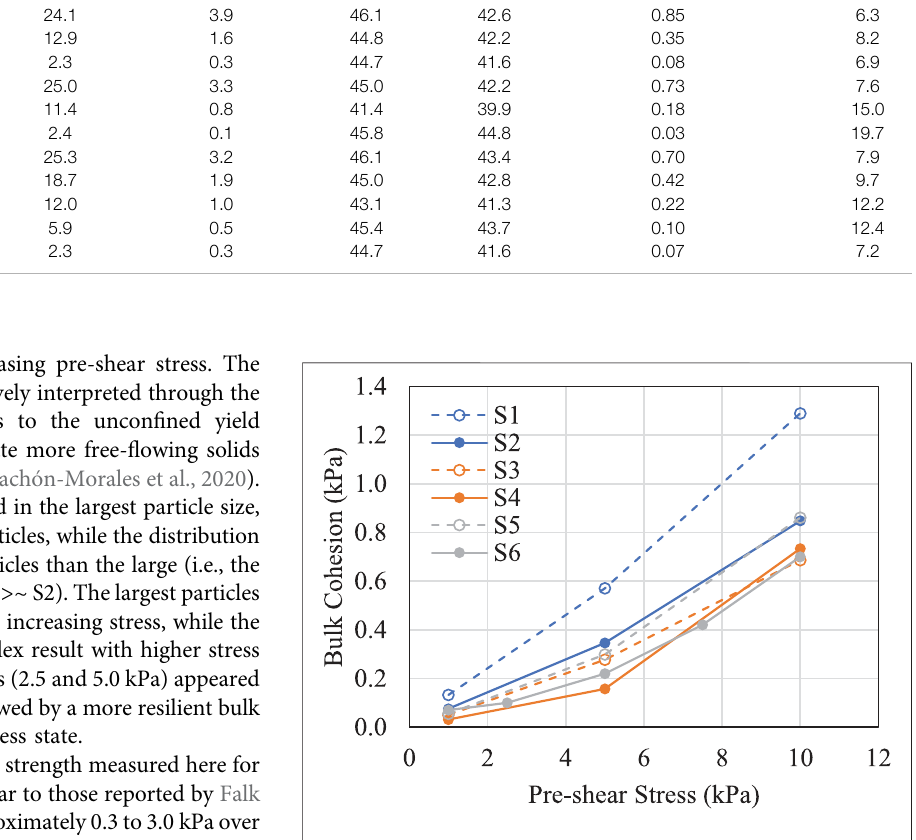
TABLE 2 | Shear properties of loblolly pine (S2, S4, and S6) from the RST. Sample Pre-shear (kPa)